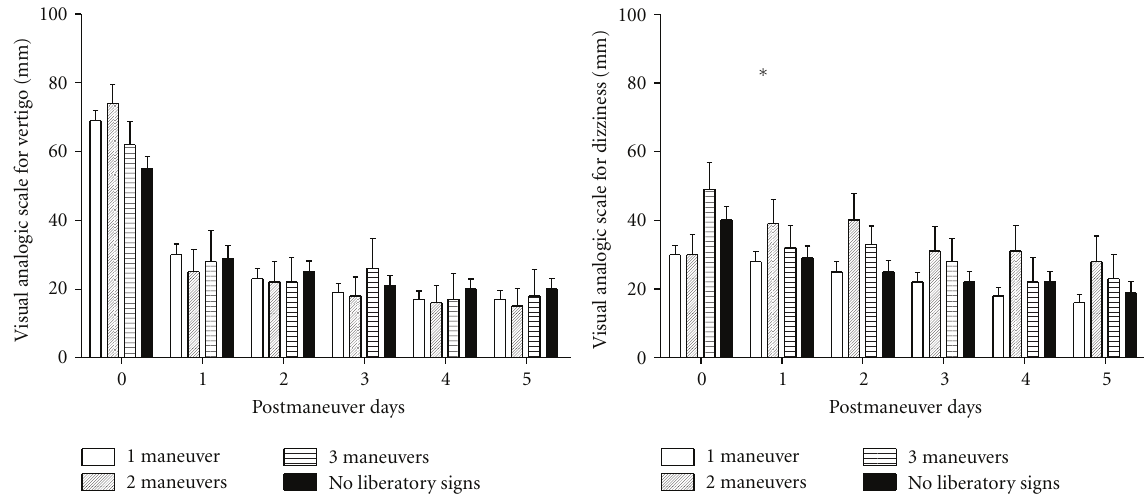
Figure 6: Time course of visual analog scale with or without postmaneuver restrictions independently from the maneuver type and liberatory nystagmus. No di ff erence could be observed in the evolution of the symptoms between the two groups (not significant, two-way ANOVA).